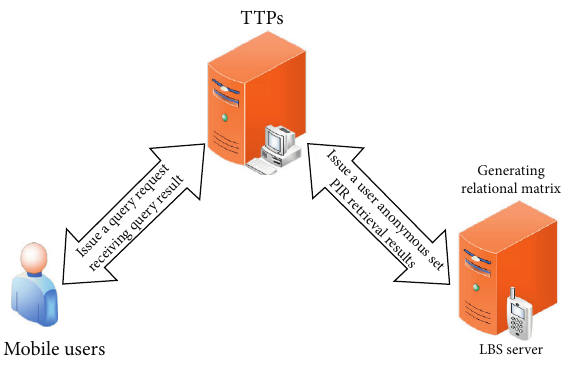
Figure 1: Communication